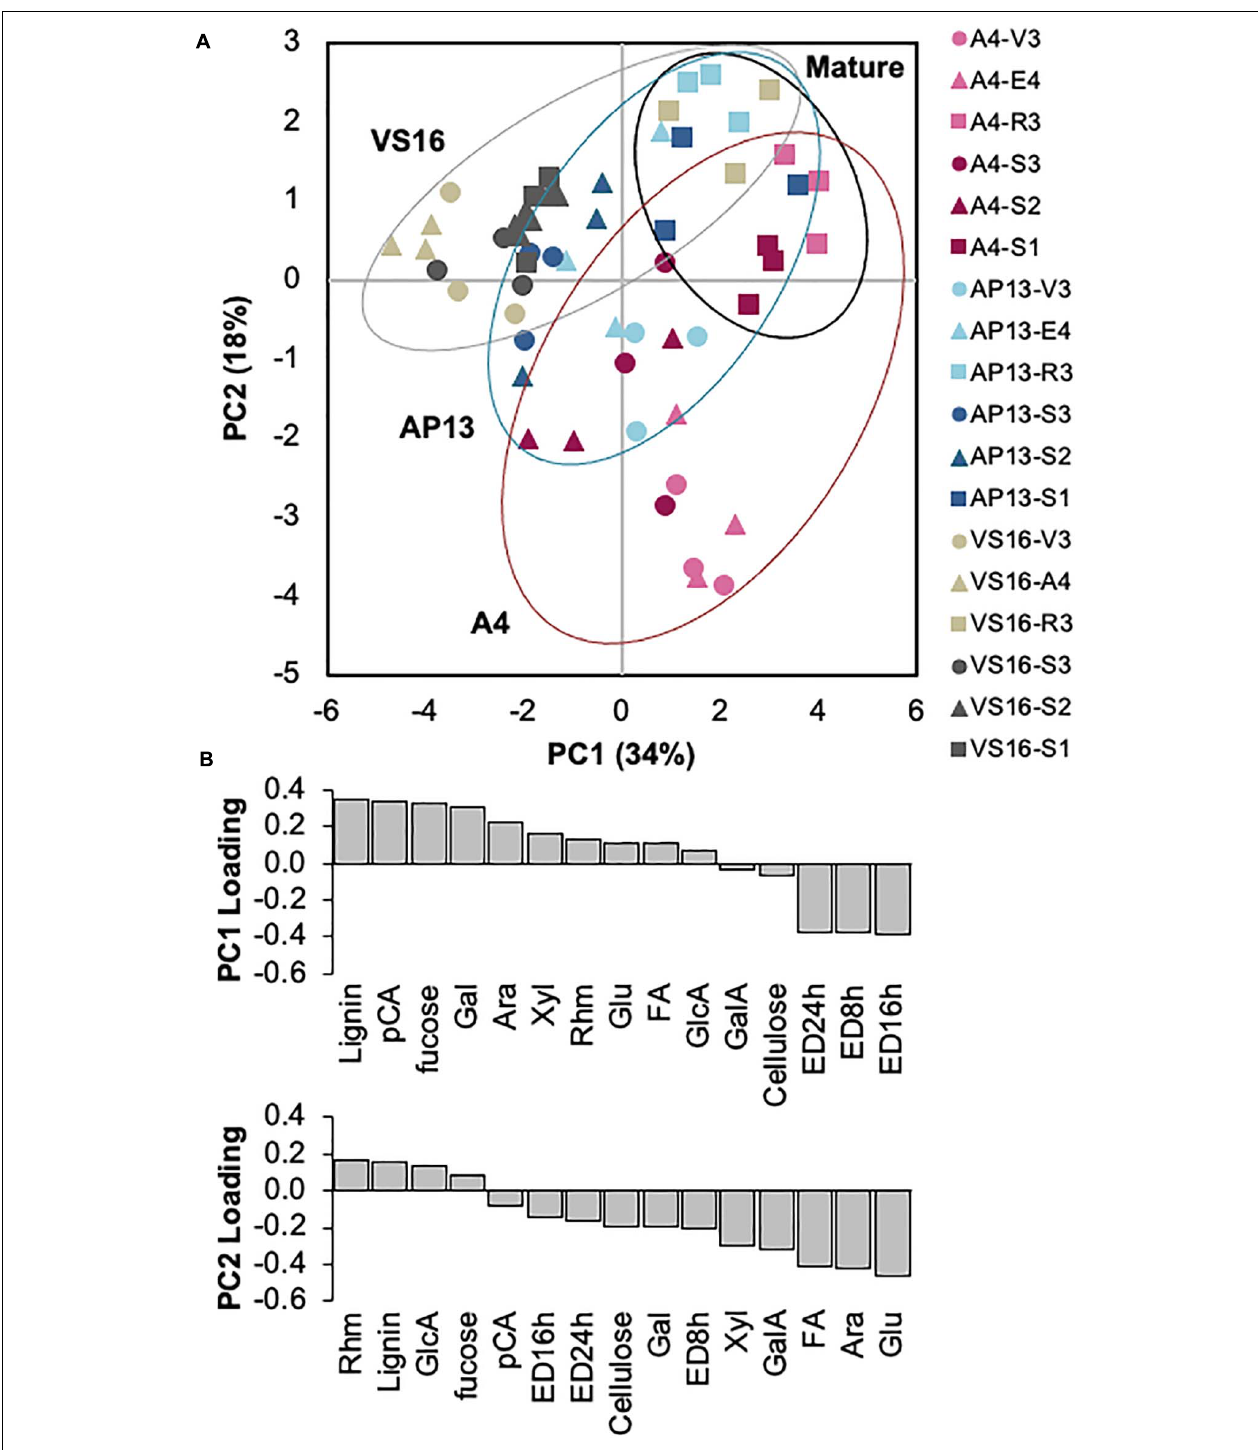
FIGURE 5 | Principal component analysis of cell wall variables indicates segregation by sample age and, partially, by genotype. (A) Distribution of samples in the first two principal components. Percentages indicate the variation represented by each component. Red indicates A4; blue, AP13; and gray, VS16. Lighter shading indicates whole tillers, and darker shading indicates segments of the elongation 4 (E4) tiller. Figure 1 diagrams the samples. Circles are younger, triangles are intermediate, and squares are older tillers/segments. (B) Loadings of the two major principal components (PC). Ara, arabinose; ED16, ED24, and ED48 h, enzymatic digestibility yield at 16, 24, and 48 h; FA,: erulic acid; Gal, galactose; GalA, galacturonic acid; GlcA, glucuronic acid; Glu, non-crystalline cellulose glucose; p CA, p -coumaric acid; Rhm,